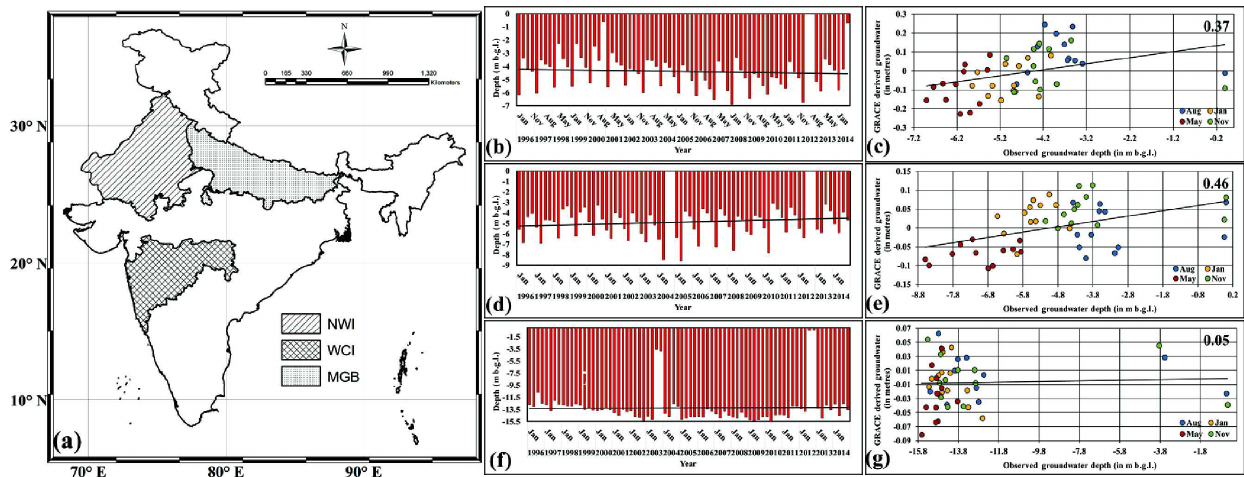
Figure 3. Validation of GRACE with well observation. (a) Sub-regions considered for study. (b) Trend of groundwater levels in the middle Ganga basin (MGB). (c) Correlation between observed groundwater levels and GRACE-derived groundwater storage for the MGB. (d) Trend of groundwater levels in peninsular India. (e) Correlation between observed groundwater levels and GRACE-derived groundwater for penin- sular India. (f) Trend of groundwater levels in north-western India. (g) Correlation between observed groundwater levels and GRACE-derived groundwater storage for north-western